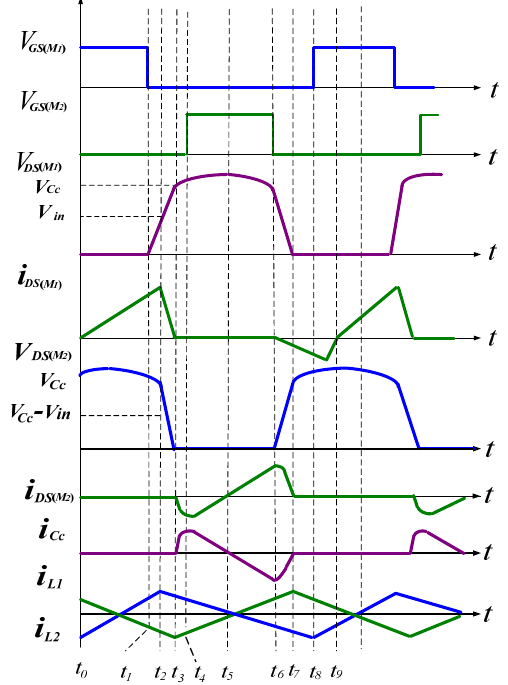
Figure 6. Driving signals and key waveforms of the proposed power supply